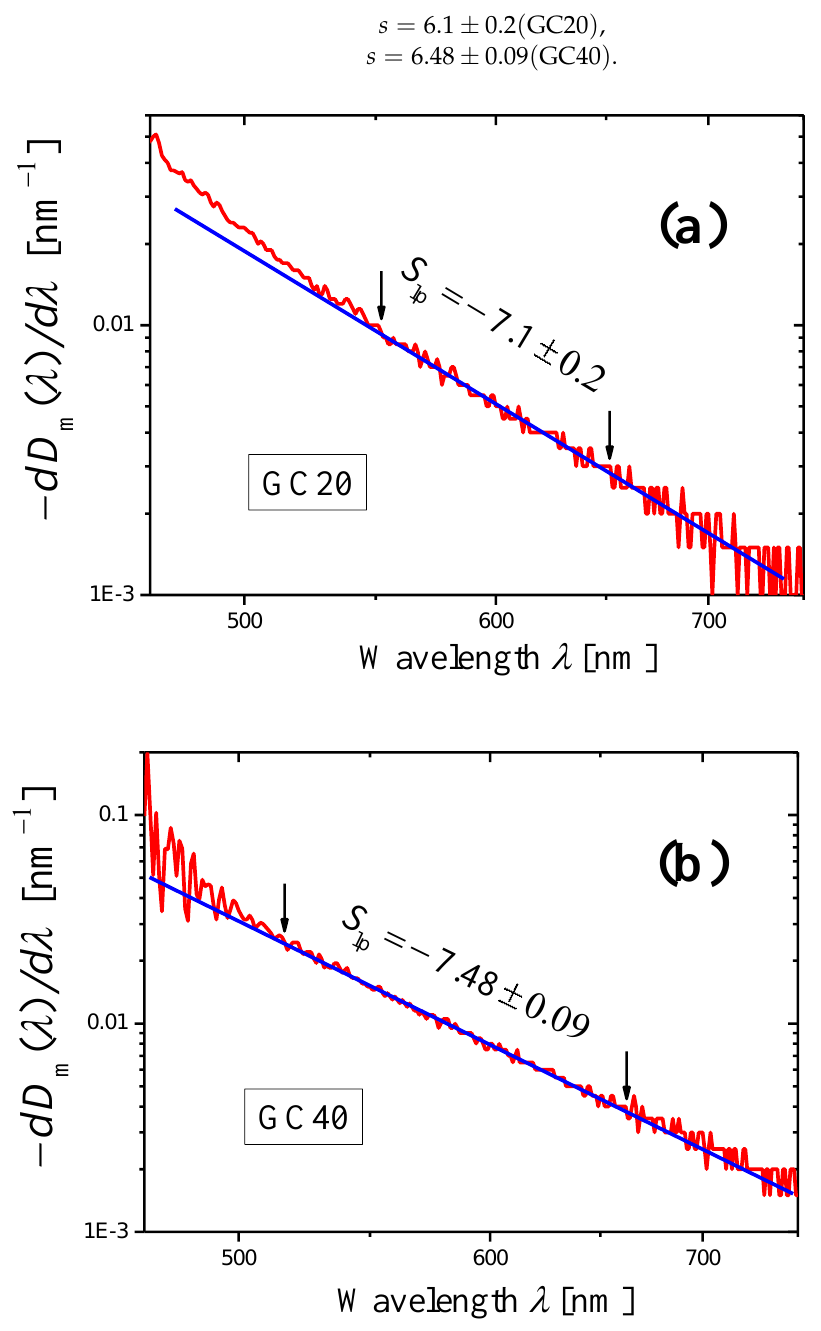
Figure 6. Log–log plots of the dependences of ( − dD i m ( λ ) / d λ ) on λ (red curves) constructed for the measured optical densities D m ( λ ) of the samples of the glass-ceramics GC20 ( a ) and GC40 ( b ). The samples have the same thickness h = 2.00 mm. The portion of each curve limited by arrows is approximated by blue straight line using the least squares method, and the slope S lp of the straight line is indicated in the figure.